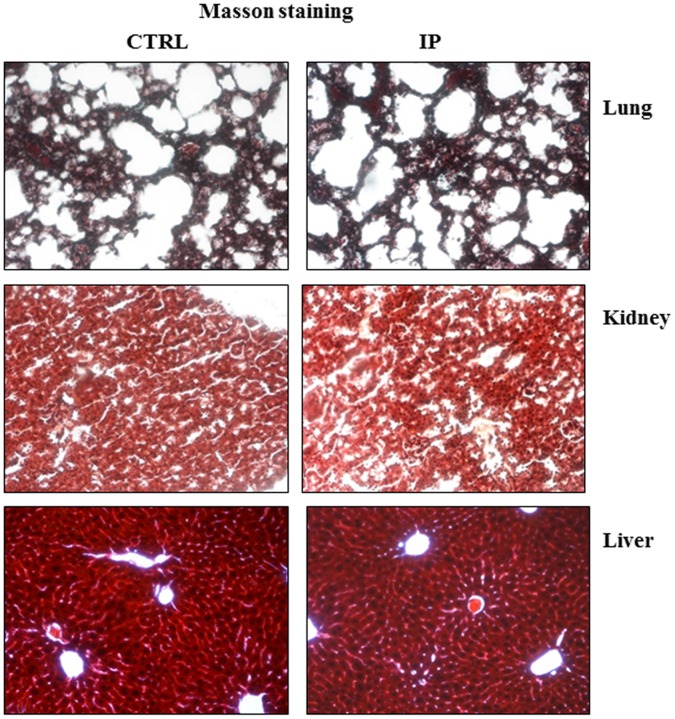
ISA27 is not toxic to normal tissues.Two weeks from the start of the treatment, mice were sacrificed, and internal organs were removed for histological analysis. Masson trichrome staining was performed on liver, kidney and lung tissues from treated and control mice. No morphological differences were found in the treated mice compared with the controls.